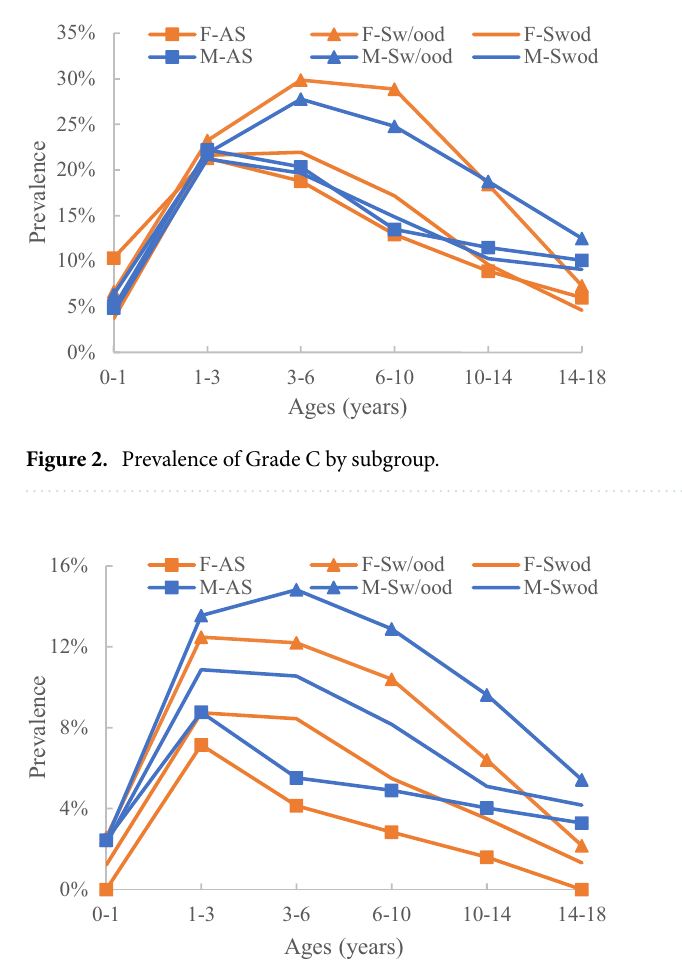
Figure 3. Prevalence of Grade B by subgroup.